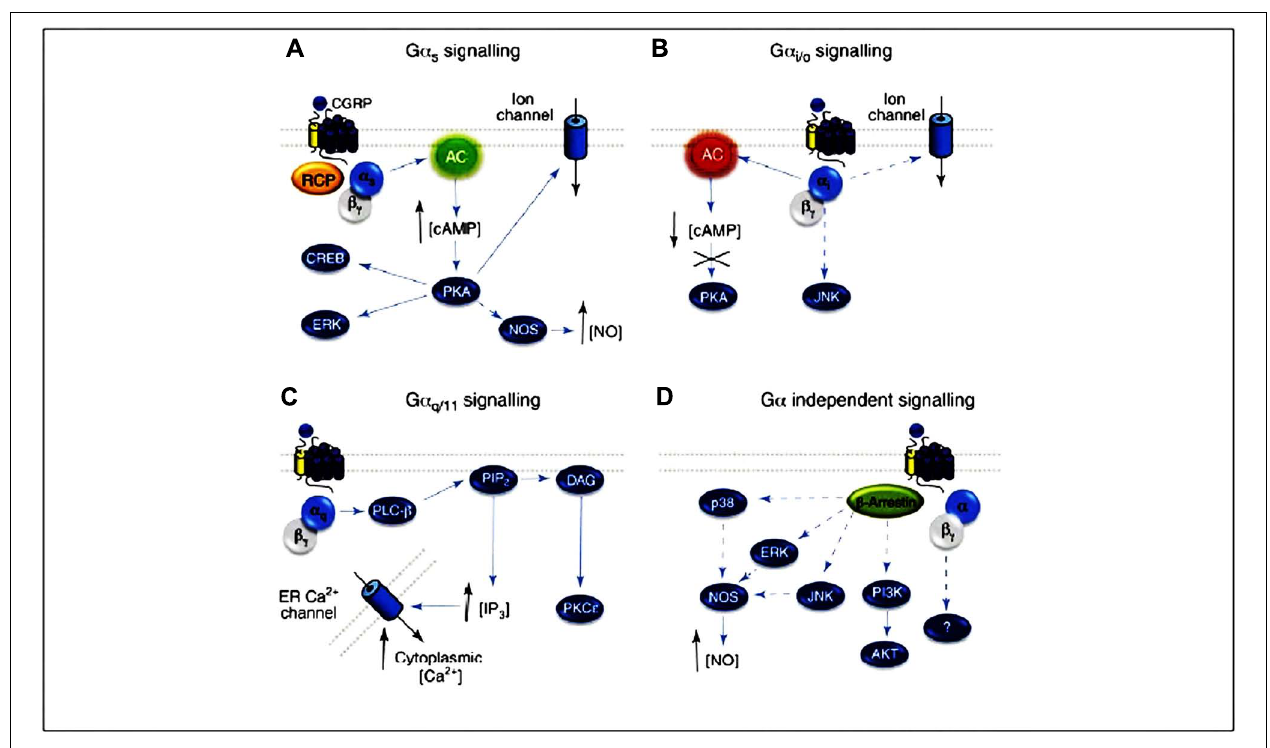
FIGURE 3 | CGRP receptor-mediated intracellular signaling. (A) Ga s signaling increases AC (green) activity, elevating intracellular cAMP, activating PKA and subsequently many potential downstream effectors. (B) The CGRP receptor might also couple to Ga i / o , reducing AC (red) activity, decreasing intracellular cAMP and reducing PKA activity. (C) CGRP signaling via Ga q activates PLC-b, which cleaves PIP 2 into IP 3 and DAG, resulting in elevated intracellular Ca 2 + and PKC activation. (D) The CGRP receptor might also utilize Ga-independent signaling, and G βγ - or b-arrestin-mediated signaling